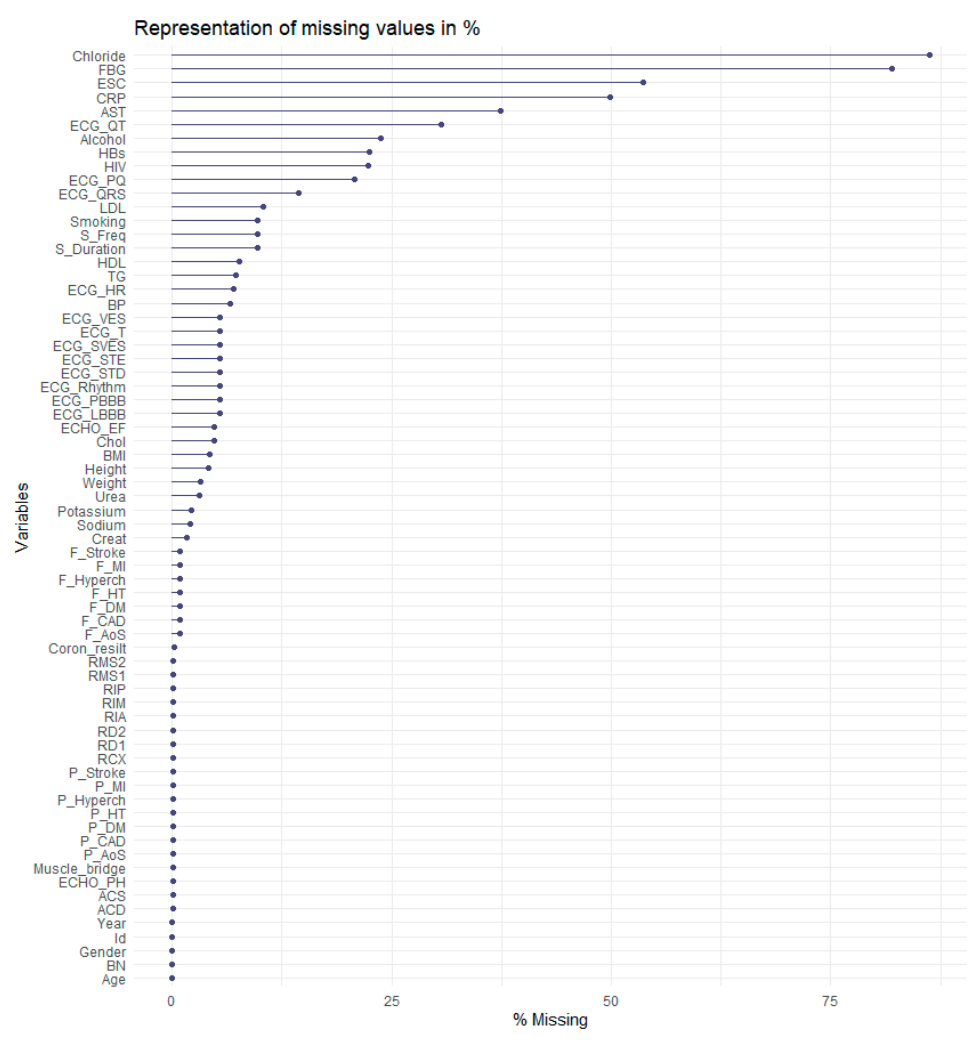
Figure 4. Representation of missing values.